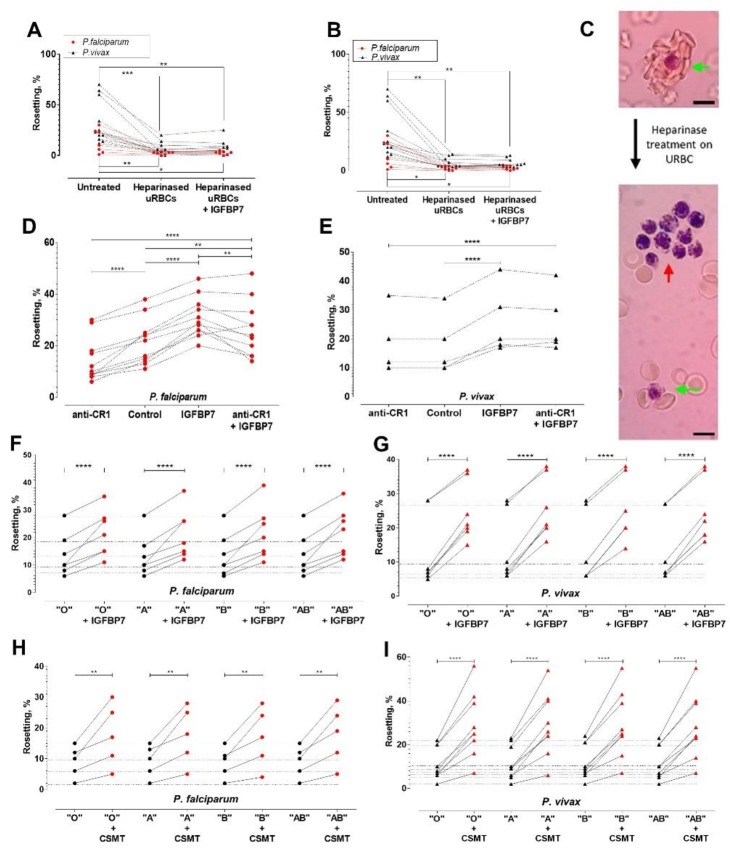
Deciphering rosetting receptors involved in IGFBP7-mediated rosetting.(A) Heparinase (hep) I treatment (represented as "heparinased" in graph) on URBC hampered IGFBP7-mediated rosetting. Friedman with Dunn’s test: Pf (n = 7): untreated vs. hep: p=0.0063; hep vs. hep + IGFBP7: p>0.9999; untreated vs. hep + IGFBP7: p=0.0334. Pv (n = 11): untreated vs. hep: p=0.0004; hep vs. hep + IGFBP7: p>0.9999; untreated vs. hep + IGFBP7: p=0.0042. (B) Hep III treatment (represented as "heparinased" in graph) on U RBC hampered IGFBP7-mediated rosetting. Friedman with Dunn’s test Pf (n = 7): untreated vs. hep: p=0.0150; hep vs. hep + IGFBP7: p>0.9999; untreated vs. hep + IGFBP7: p=0.0485. Pv (n = 11): untreated vs. hep: p=0.0013; hep vs. hep + IGFBP7: p>0.9999; untreated vs. hep + IGFBP7: p=0.0013. (C) Rosette size difference between the untreated (left) and heparinase-treated (right) settings of a P. vivax isolate. Rosettes are indicated by green arrows, and IRBC- autoagglutination-like clustering is indicated by the red arrow. Pictures taken with Samsung Galaxy W phone camera on Nikon Eclipse E200 light microscope. Scale bars represent 10 µm. (D) Anti-CR1 reduced Pf (n = 11) rosetting (one-way ANOVA with Tukey’s test: p<0.0001). With CR1-blockade, IGFBP7 still managed to induced significant rosette-stimulation (p=0.0057), albeit to a lower degree than Ab-free setting (p=0.0095). (E) Anti-CR1 did not inhibit Pv (n = 5) rosetting [one-way ANOVA with Tukey’s test: p=0.9947]. IGFBP7 increased rosetting (p<0.0001). No significant difference was found between IGFBP7 and anti-CR1+IGFBP7 groups (p=0.9612). Effect of different ABO blood groups on IGFBP7-mediated rosetting for Pf (n = 7) (F) and Pv (n = 7) (G). Dotted horizontal lines in these plots matched the same isolates used in each of the different ABO blood group experiments. IGFBP7 significantly increased rosetting rates regardless of the blood groups [one-way ANOVA with Tukey’s test: (Pf: p<0.0001 for all groups); (Pv: p<0.0001 for all groups)]. No significant differences in rosetting rates (control and IGFBP7-supplied) across all blood groups for both species. The degree of rosette stimulation by CSMT on Pf (n = 5) (H) and Pv (n = 9) (I) with URBC of different ABO blood groups. Dotted lines in these plots matched the same isolates used in each of the different blood group experiments. CSMT increased rosetting regardless of the blood groups [one-way ANOVA with Tukey’s test: (Pf: Group O: p=0.0014; Group A: p=0.0018; Group B: p=0.0033; Group AB: p=0.0010); (Pv: p<0.0001 for all blood groups)]. No significant differences were found in rosetting rates (control and CMST-supplied) across all groups for both species.